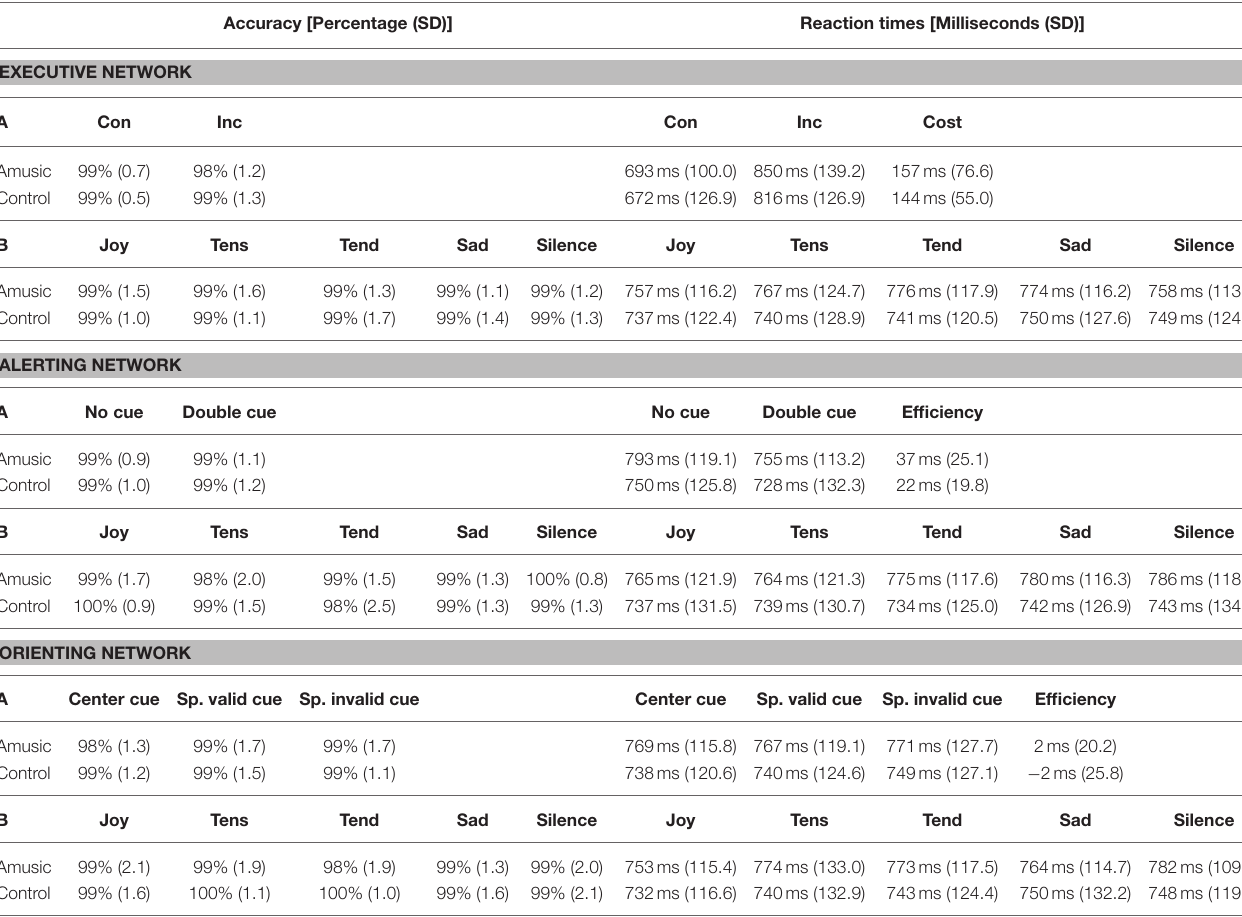
TABLE 3 | Behavioral scores in the Attention Network Task (ANT) for measures assessing executive control, alerting, and orienting components, for both the amusic and control